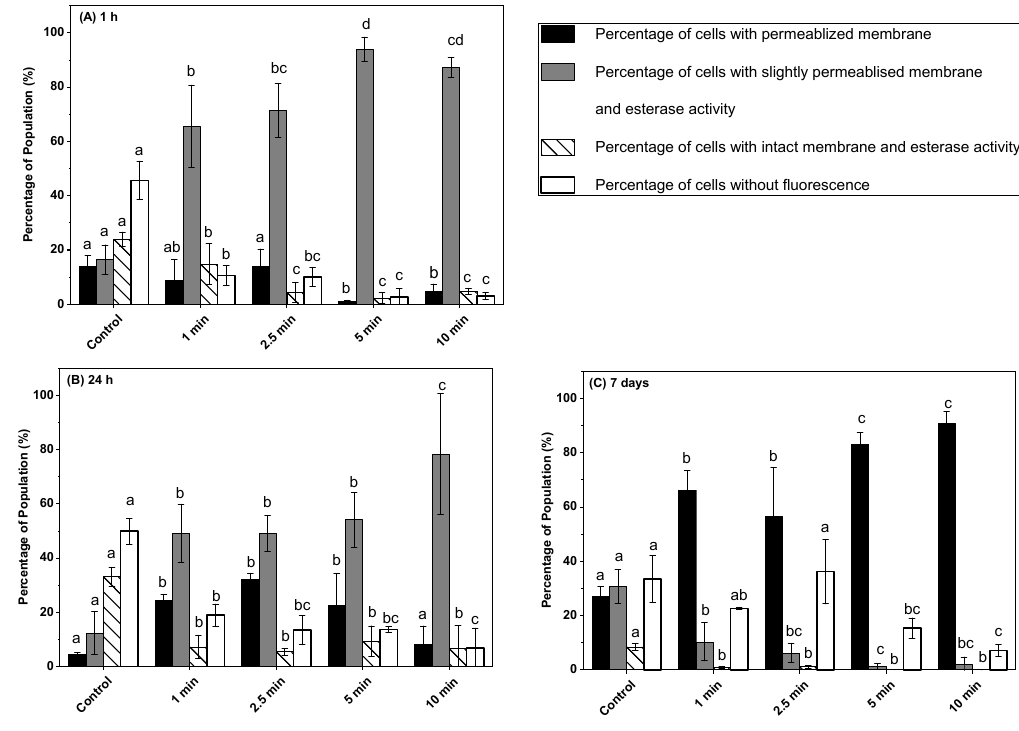
Figure 3. Esterase activity and membrane integrity measurements of L. monocytogenes cells on ham surfaces using cFDA and PI in combination after in-package ACP treatment storage at 4 °C for ( A ) 1 h, ( B ) 24 h, ( C ) 7 days. Black bar represents permeabilized cells (PI- fluorescence); grey bar represents slightly permeabilized cells with esterase activity (cFDA + PI fluorescence); white bar with hatch lines represents intact cells with esterase activity (cFDA fluorescence); white bar represents cells without fluorescence. Data are shown as means ± standard deviations ( n = 3). Treatment means with different letters are significantly different.